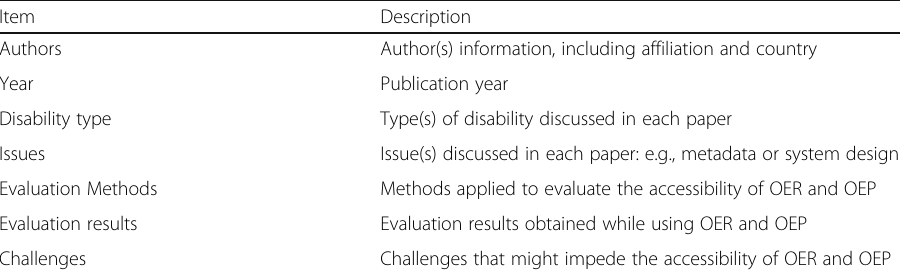
Table 2 Coding scheme during the literature review